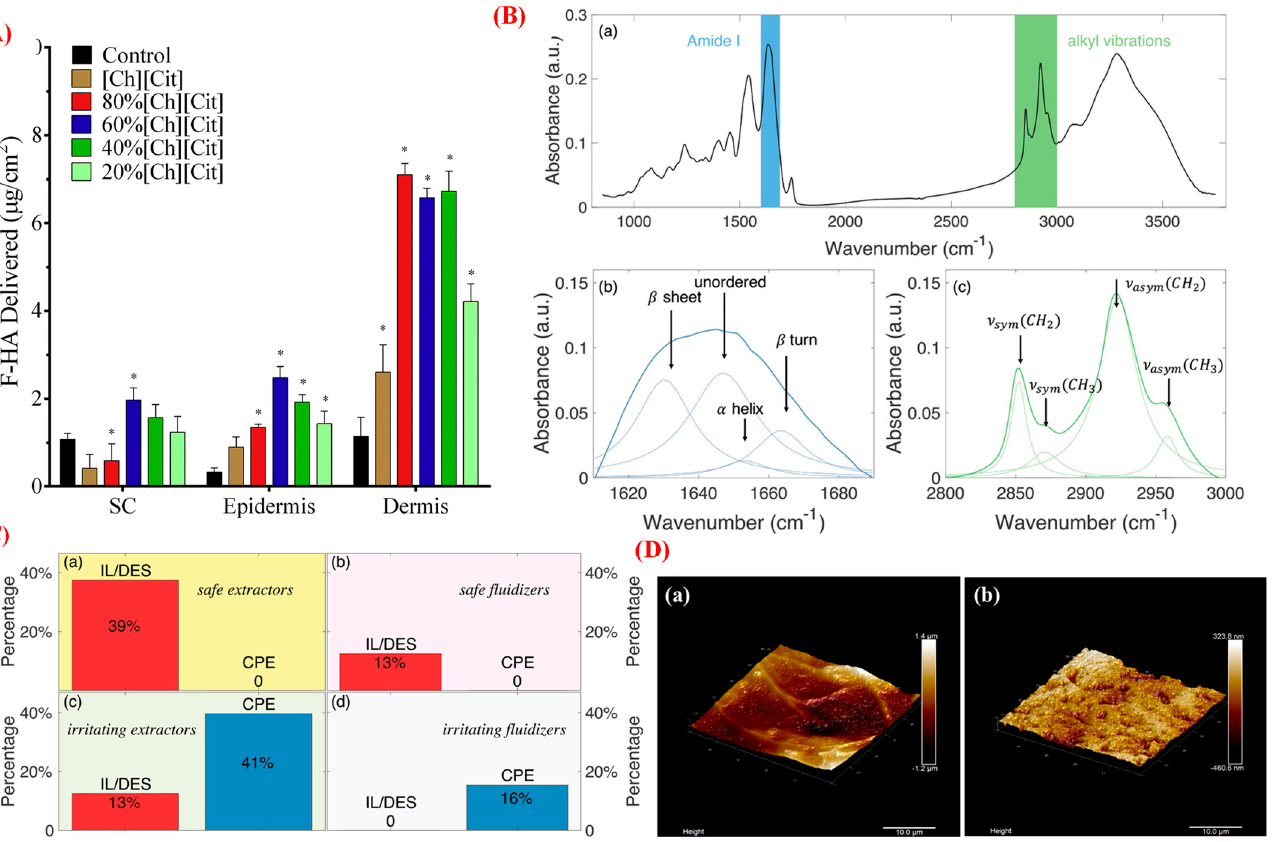
Figure 4. ( A ) The total amount of fluorescence hyaluronic acid (F-HA) determined in SC (stratum corneum), epidermis and dermis layer of the skin using choline citrate. Data represented as mean ± SD for n = 3 and * p < 0.05 compared with the control group [45]; ( B ) FTIR spectra of blank SC samples ( a ) with deconvoluted peaks in the amide I region ( b ) and lipid region ( c ) [46]; ( C ) A comparison of percentages of ILs/DESs (red) and CPEs (blue), representing ( a ) safe extractors, ( b ) safe fluidizers, ( c ) irritating extractors, and ( d ) irritating fluidizers [46]; ( D ) AFM images of SC samples treated with PBS solution ( a ) or IL-ME ( b ) [48]; reproduced with permission from refs.